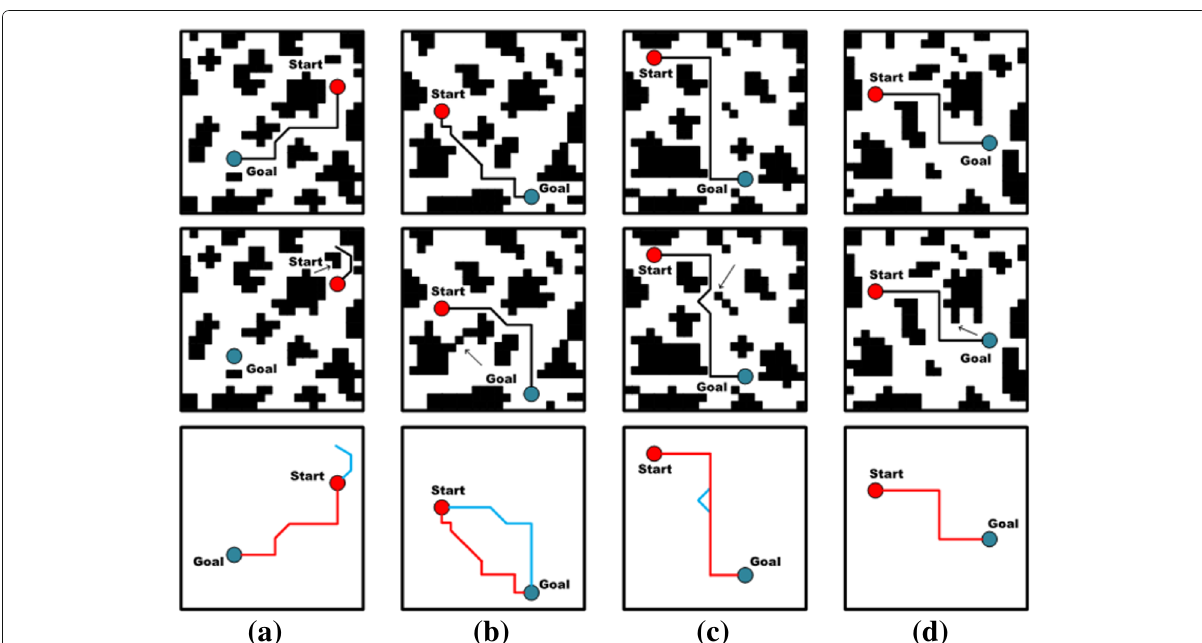
Fig. 12 Four categories of VIN adversarial maps. The first line denotes the original maps, the second line represents the adversarial eaxmples generated, and the third line is the extracted path image. a The UrP. b The FP. c The DP. d The UcP